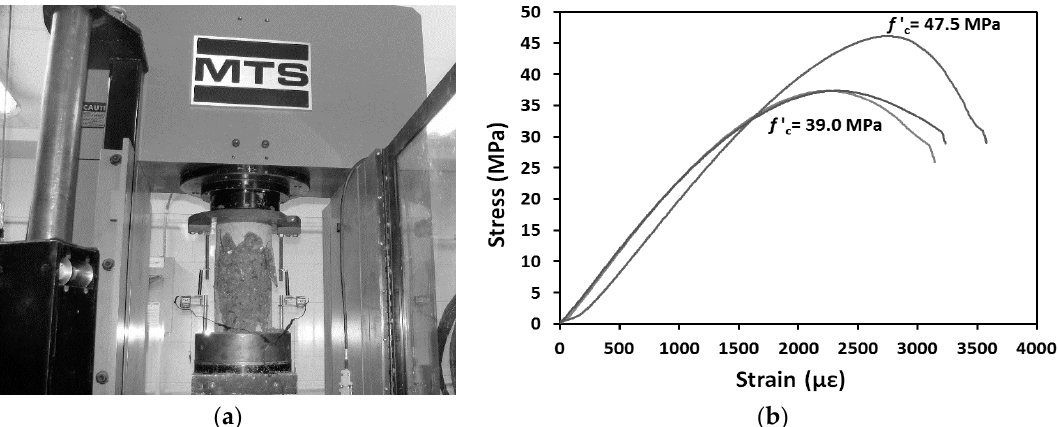
Figure 1. ( a ) Compression test of concrete cylinders; ( b ) typical axial stress-strain relationships for concrete